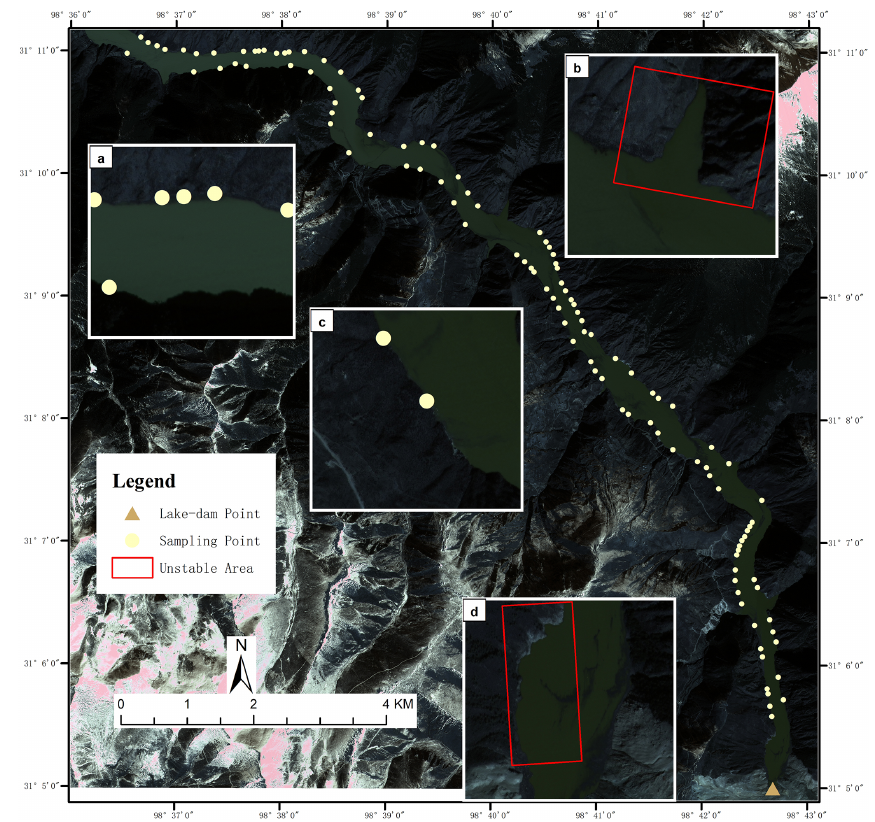
Figure 6. The sampling points in the case of the Baige landslide dam (image from the Beijing-1 satellite). Table 1. Sources of input data used in the Hongshiyan landslide dam